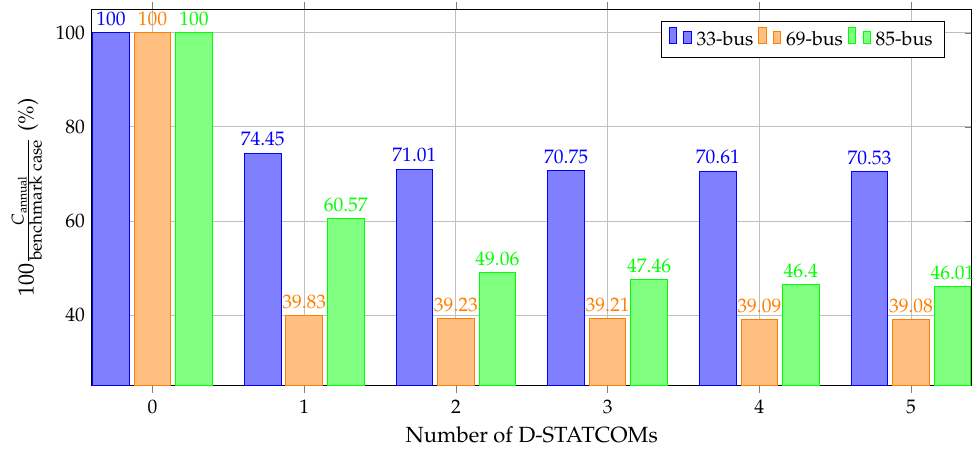
Figure 4. Percentage reduction in annual operating costs regarding the benchmark case by number of D-STATCOMs.